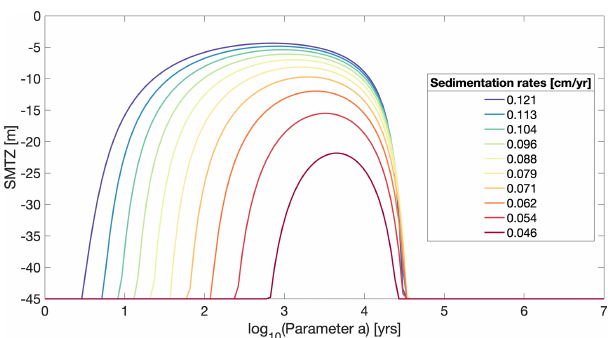
Figure 7. Depth of the SMTZ as a function of OM reactivity pa- rameters and sedimentation rates ( ω ). For log 10 (a) < 2 . 9 years and log 10 (a) > 4 . 5 years, SO 2 − always reaches the bottom of the model 4 domain. OM is 1wt%; ν = 0 .